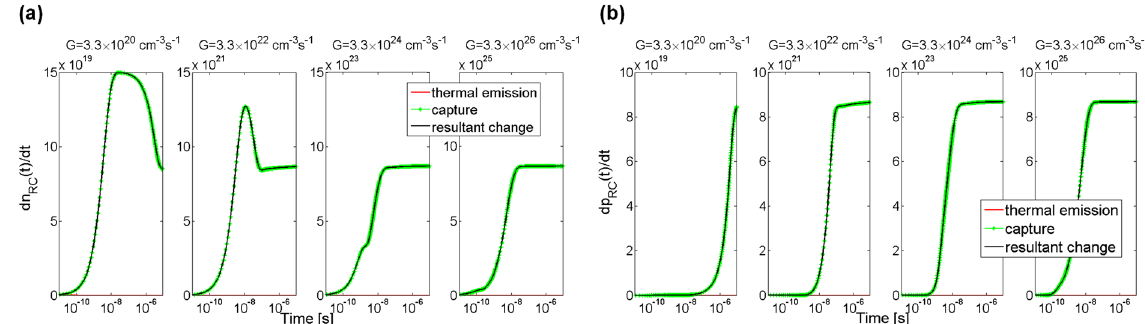
Figure 11. Simulation of the rate of exchange of electrons between the recombination centre and the conduction band ( a ) and of holes between the recombination centre and the valence band ( b ) in 4H-SiC material. The green lines show rates of capturing electrons from the conduction band and holes from the valence band, and the red lines show rates of thermal emission of electrons and holes from the centre. As there is no thermal emission present, a resultant rate of exchange of electrons and holes (black lines) is a consequence of the capturing process itself.